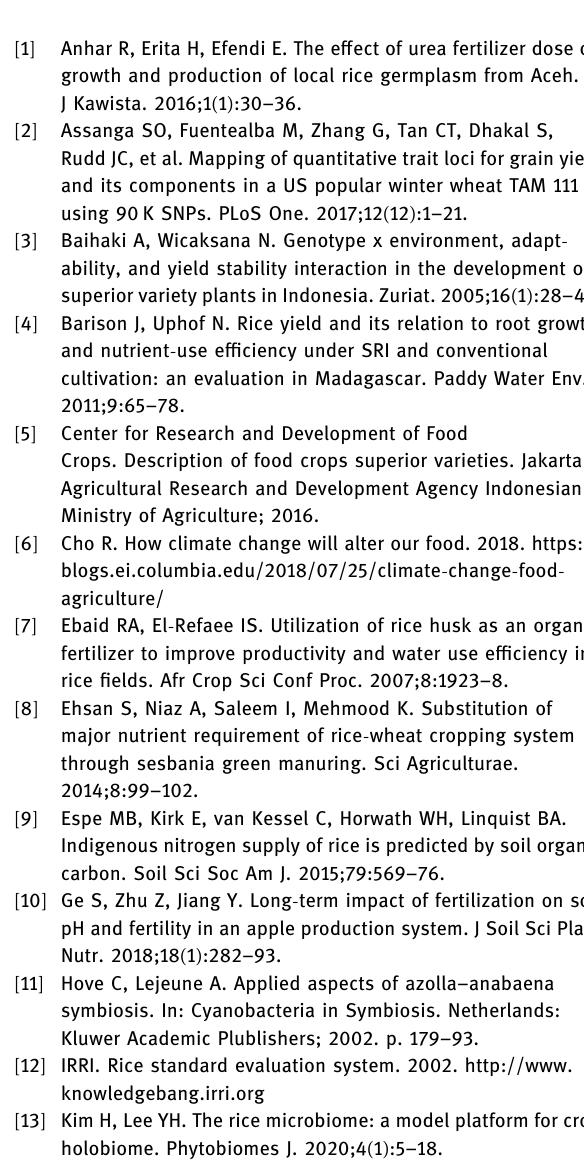
Varieties Treatments Average